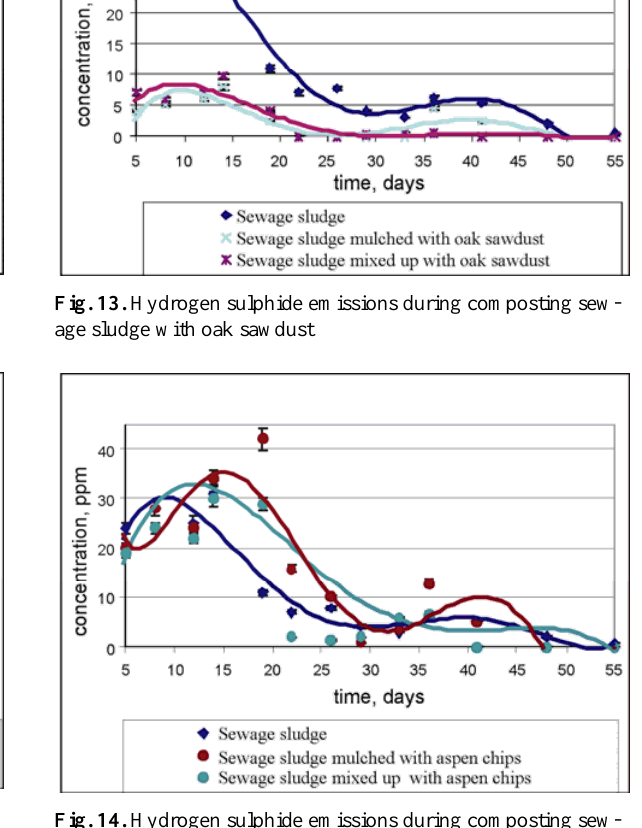
Fig. 14. Hydrogen sulphide emissions during composting sew- age sludge with aspen